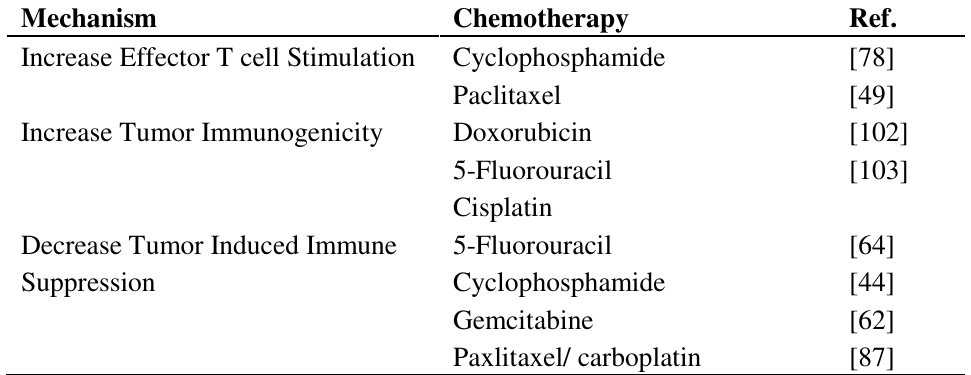
Table 3. Mechanisms of chemotherapies that could be used with cancer